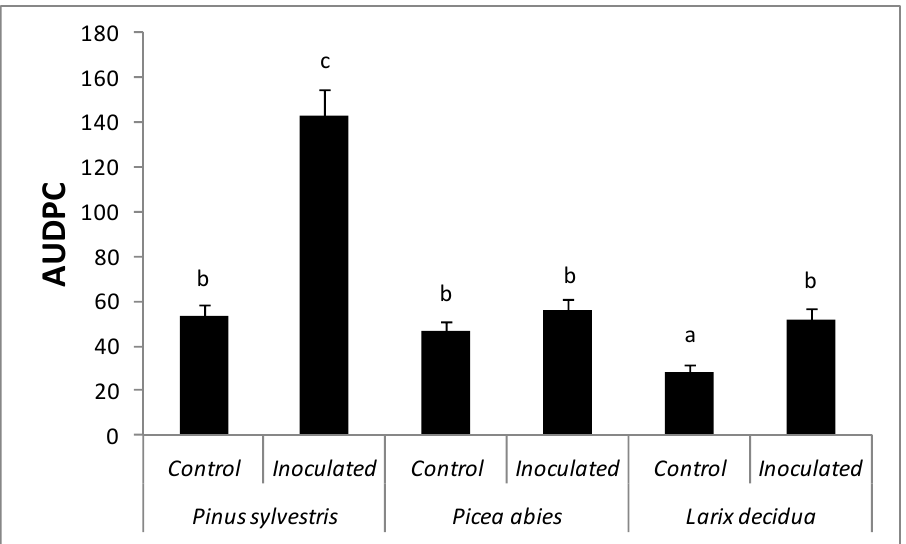
Figure 3. Comparison of area under the disease progress curve (AUDPC) for Pinus sylvestris , Picea abies , and Larix decidua seedlings. Different letters above bars indicate significantly different means (Generalized Welch procedure 0.1 trimmed means, p < 0.05).